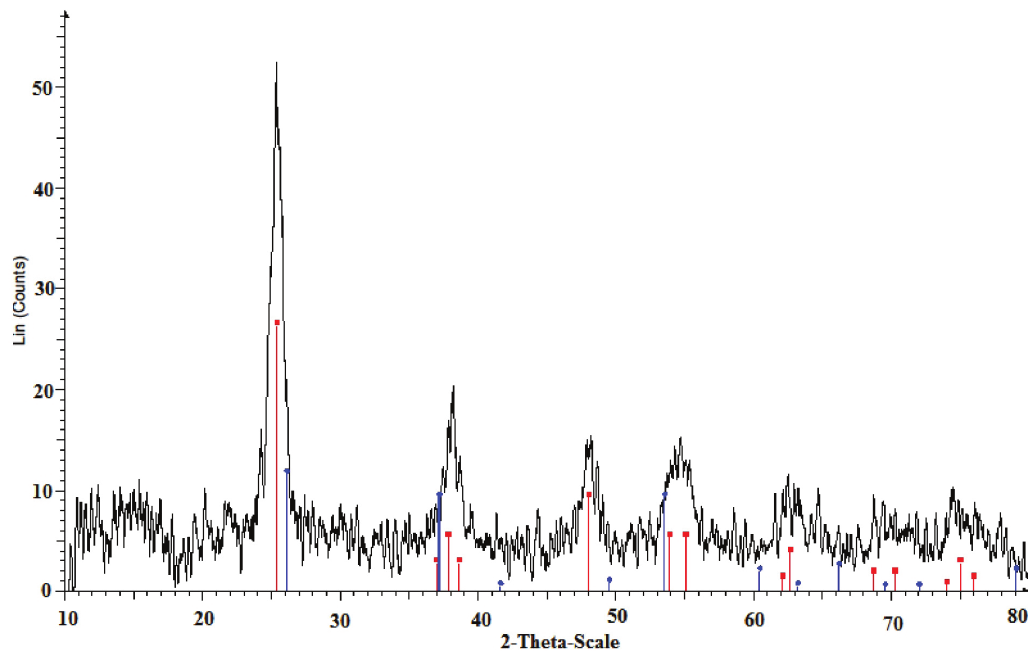
Fig. 1 – XRD pattern of Mn, Mo, la/Tio